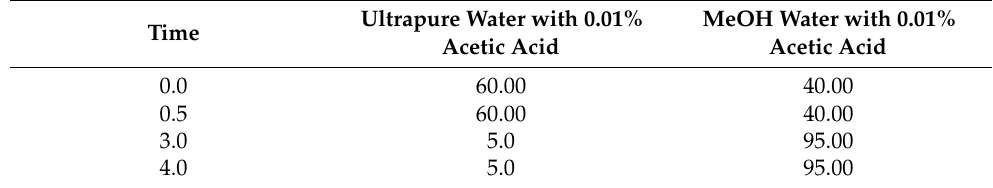
Table 1. Gradient chromatographic elution optimized to separate BPs.